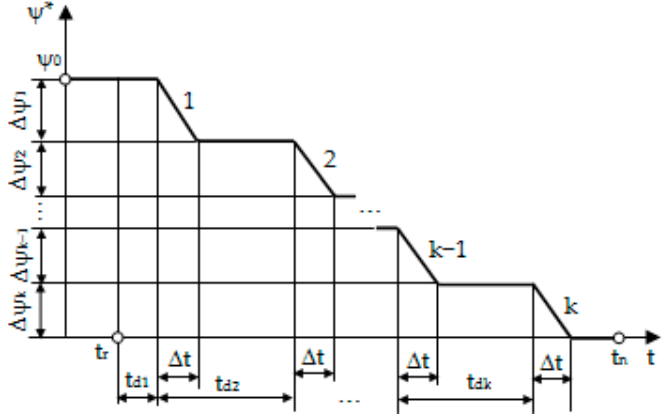
Figure 14. Parameters defining the half-law for diurnal movement.